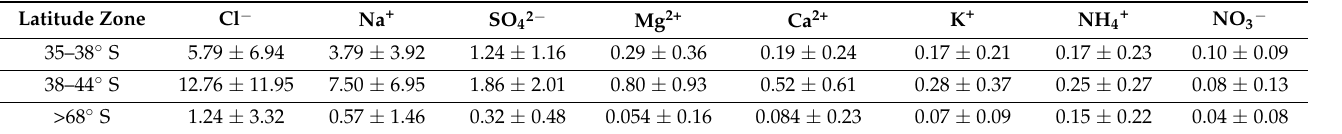
Table 2. Average values and standard deviations ( ± SD) of water-soluble ion concentrations ( µ g/m 3 ). Latitude